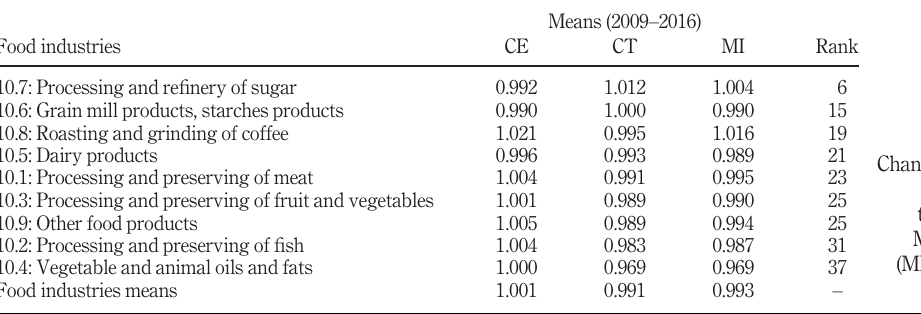
Table 4. Changes in ef fi